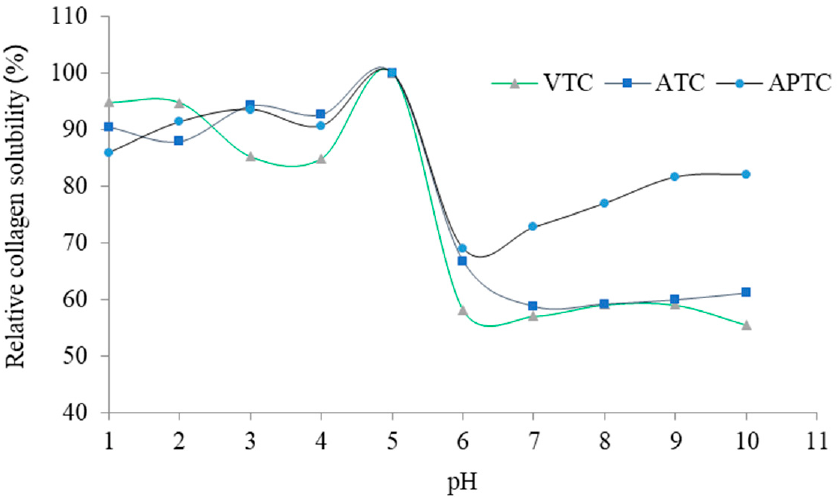
Figure 2. The effect of pH on protein solubility of tuna-tendon collagens (VTC: acid-solubilized collagen using vinegar extraction, ATC: acid-solubilized collagen using acetic-acid extraction, and APTC: pepsin-solubilized collagen).